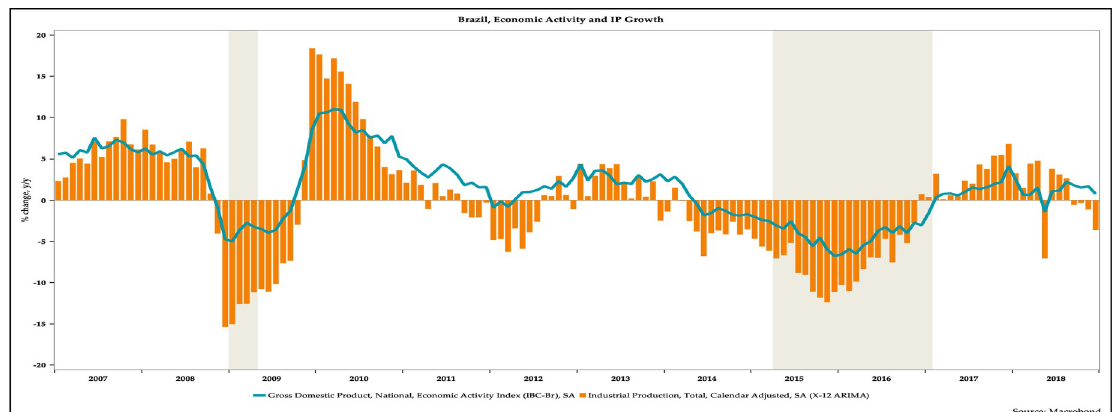
Fig 3. The evolution of economic activity and industrial production in Brazil, 2007–2018.